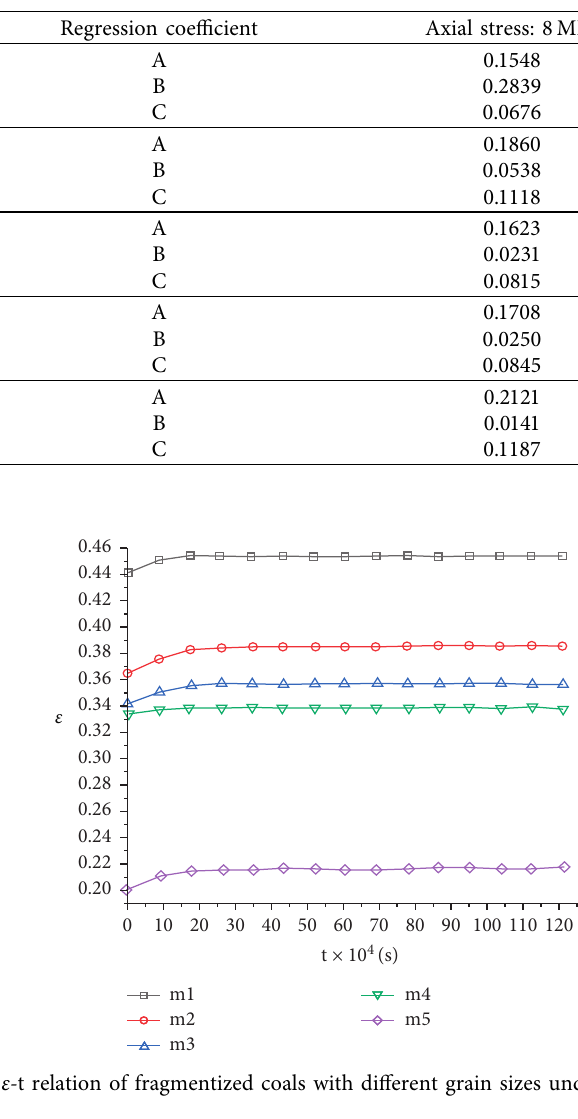
Table 2: Fitted equation coefficients of fragmentized coals under different axial stresses.